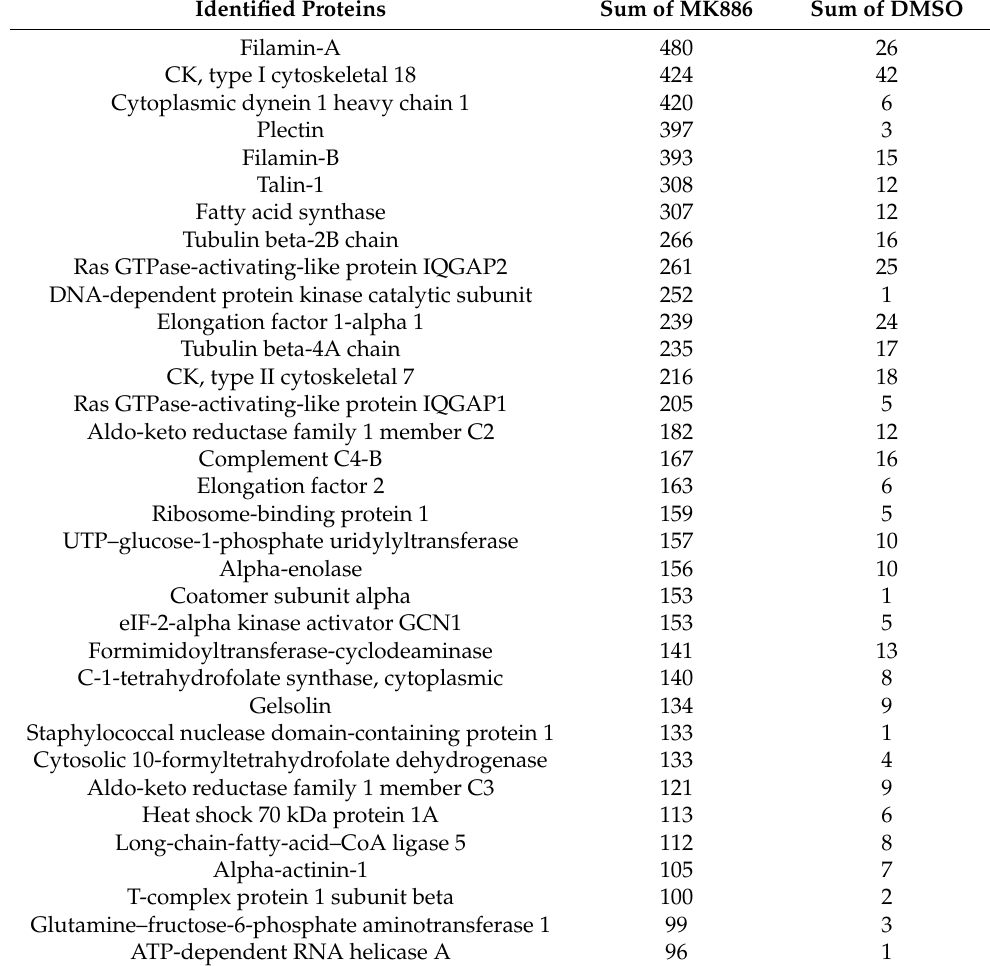
Table 2. Proteomics analysis of combined soluble and ECM fraction of donor 1 PHH spheroids treated with 100 µ M MK886 for 72 h. The 31 most highly expressed proteins in MK886 treatment that are >10-fold increased by MK886 versus DMSO in the combined soluble and ECM fraction. Data are from triplicate MK886/DMSO ECM fractions. ‘Sum of MK886 (cid:48) or ‘Sum of DMSO’ shows the total expression of a given protein in each